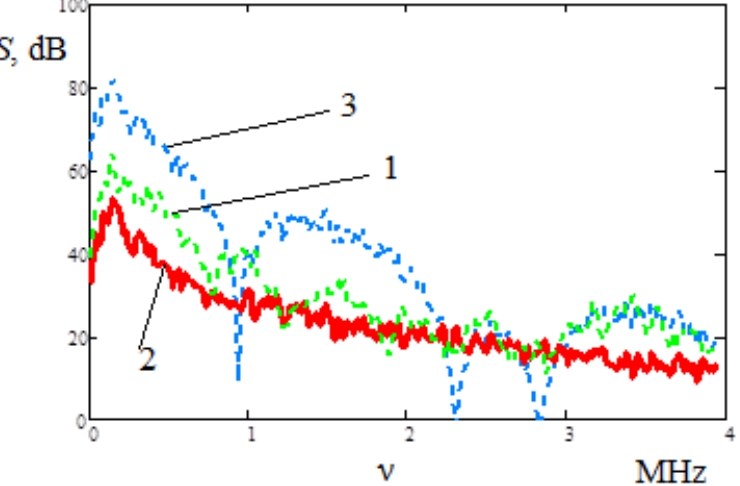
Figure 9. Spectra S ( ν ): 1—experimental OA response from [9], 2—calculation according to the model with chaotic interference; 3—calculation according to the model with full interference. The diameter of the spheres is 1 μm.